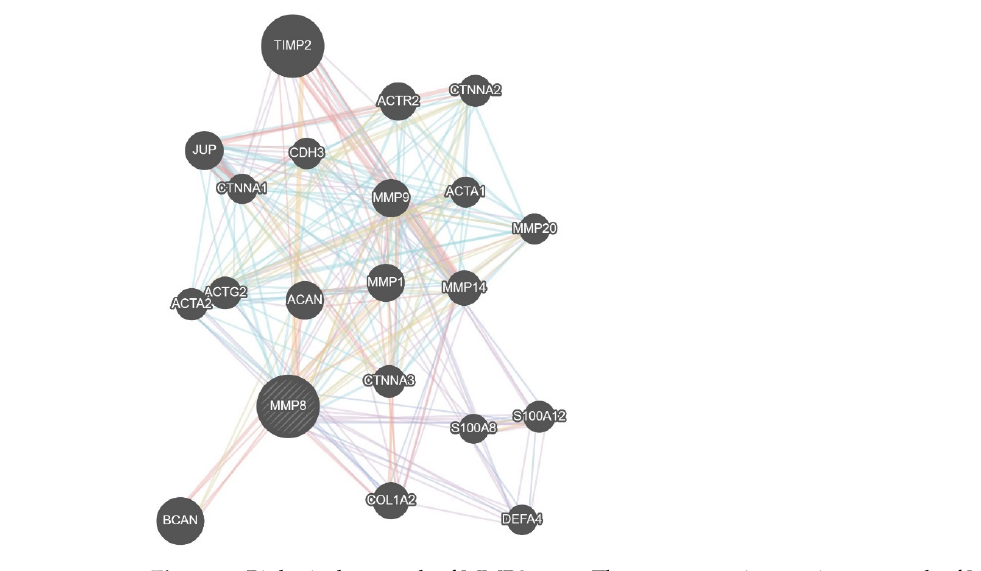
Figure 3. Biological network of MMP8 gene. The gene–gene interaction network of MMP8. The data were derived from the GeneMANIA database (https://genemania.org/)